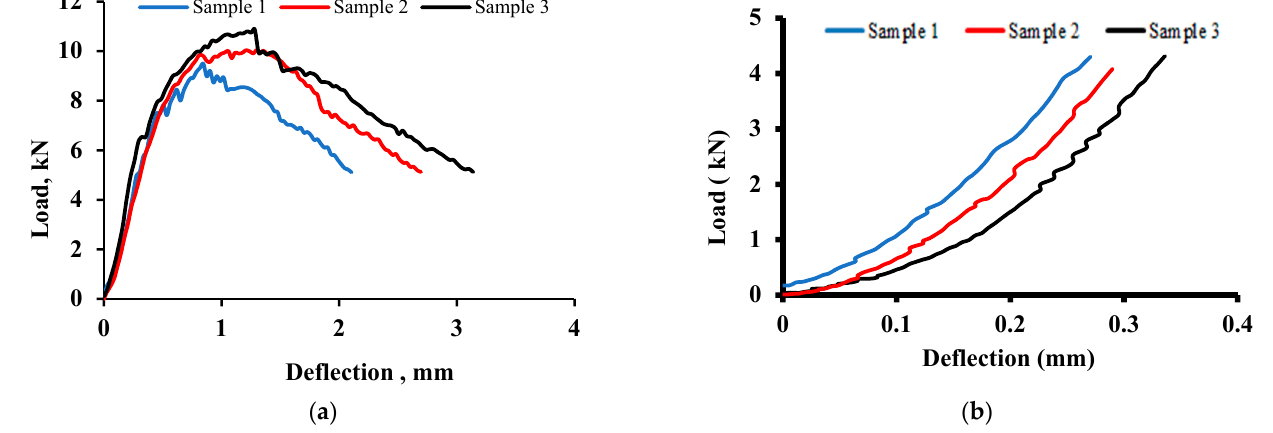
Figure 5. Typical load–deflection plot for ( a ) UHPC prisms under flexure and ( b ) UHPC prisms without steel fibers.